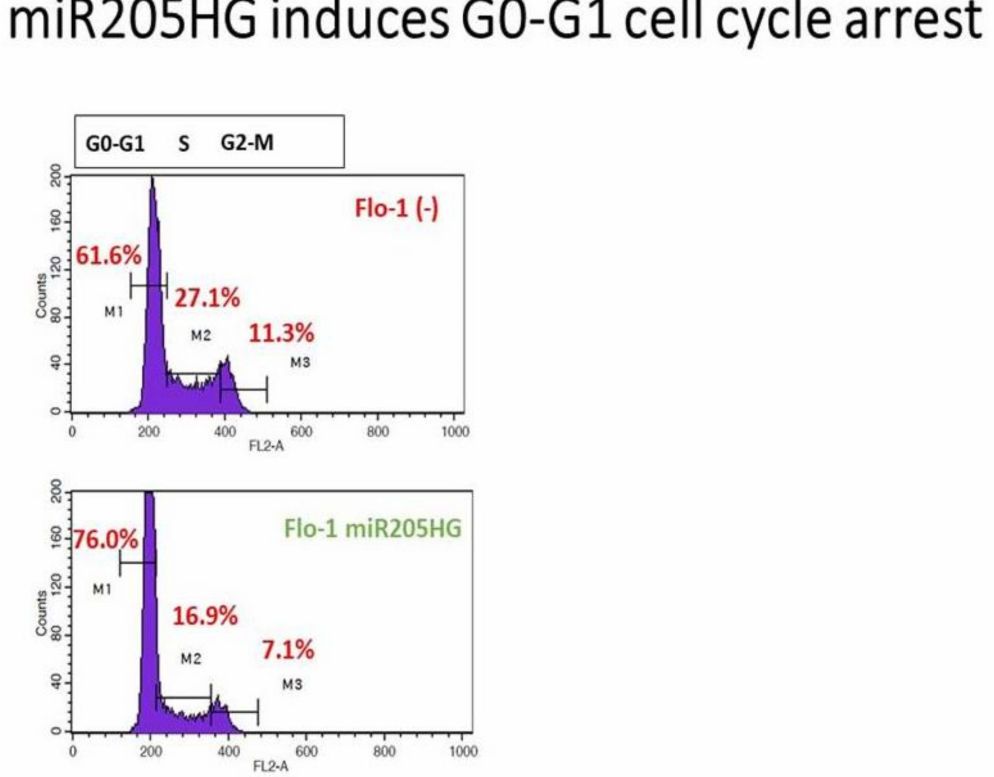
Figure 10. G0/G1 cell cycle arrest induced by miR205HG overexpression. Flow cytometric cell cycle assays demonstrated that relative to empty-vector transfected control cells; miR205HG overexpression led to an accumulation of cells at G0/G1- phase and a decrease in cells at